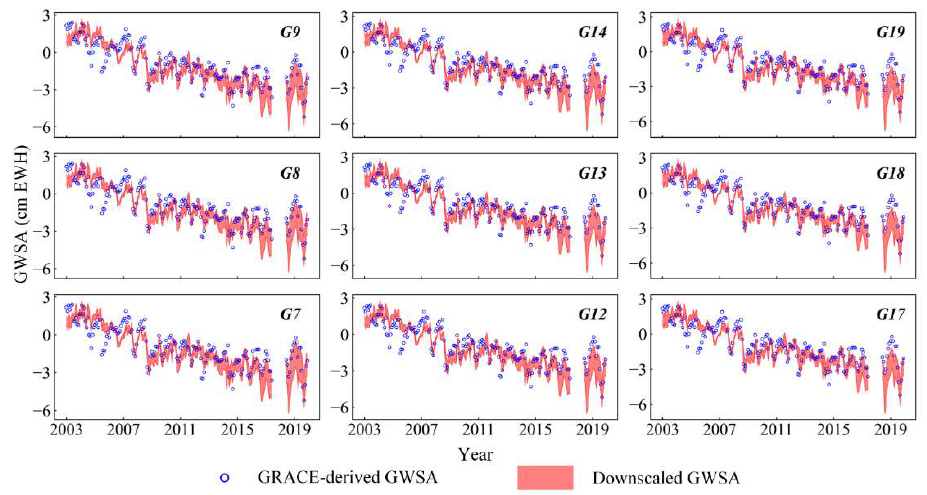
Figure 7. Time-series trend of downscaling results from 2003 to 2019. The red band represents the changes in GWSA within all 0.05° grids under the 1° grid, and the blue scatters represent GRACE-derived GWSA in the 1° grid.